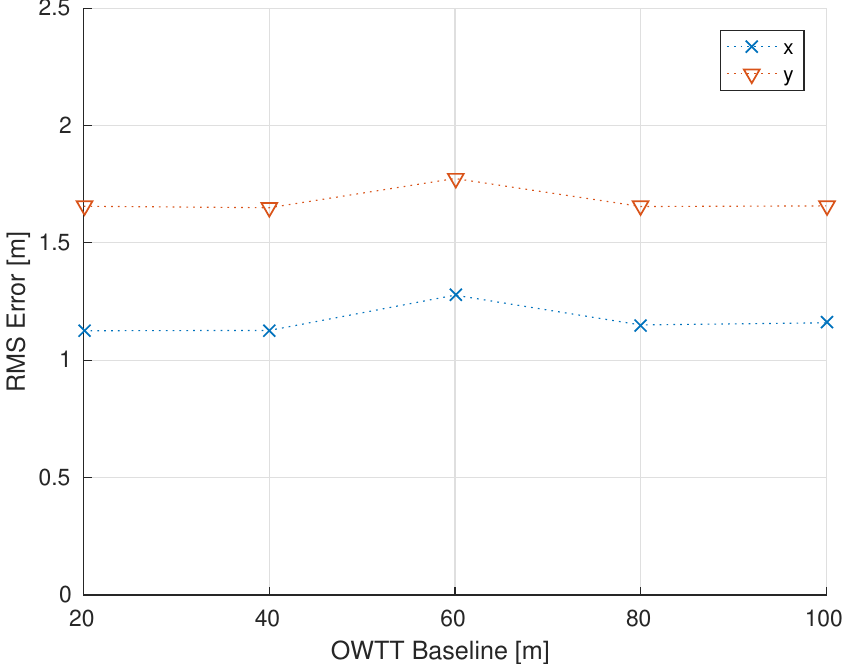
Figure 7. Ice-relative vehicle x − y position RMS error averaged over the 7.7 km ice relative vehicle trajectory for varying OWTT baselines. A 500 m GNSS line configuration and constant 0.25 m/s and 2 deg/h linear and angular ice velocity were simulated. Ice-relative vehicle position error appears effectively insensitive to transducer spacing. For reference, the end of mission vehicle-ship stand off distance was approximately 1220 m.